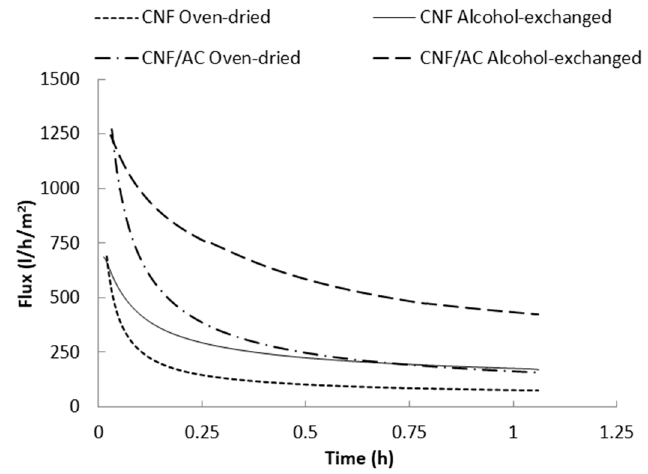
Figure 5. Water flux of the CNF and CNF/AC membranes dried with and without isopropyl alcohol exchange.